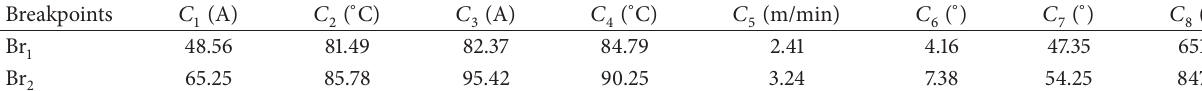
Table 2: The corresponding breakpoints of each attribute value at ℎ = 2 .